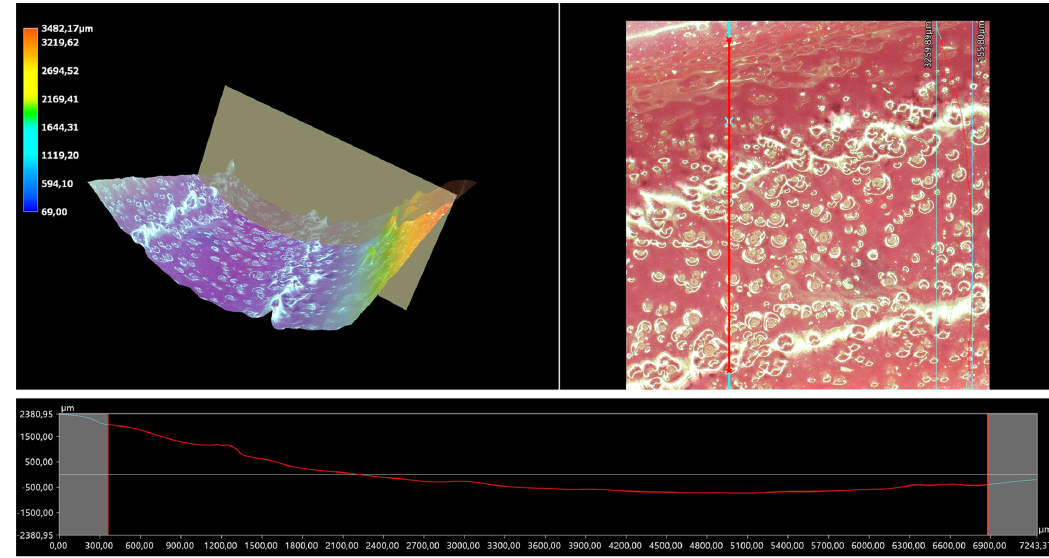
Figure 14. A 3D view of the roughness profile of sample 0.150/Photo. Table 5. The roughness parameters of hydrogels.